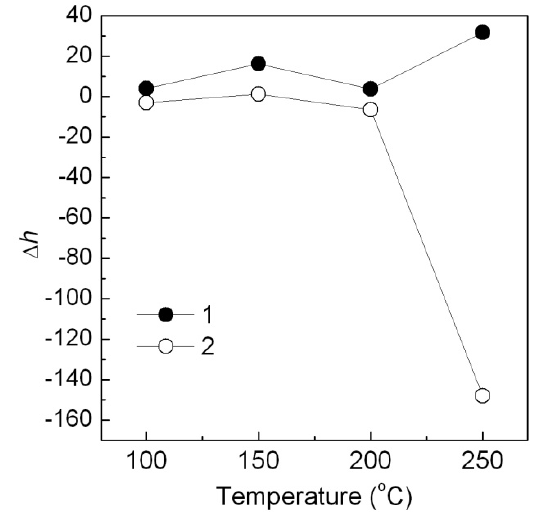
(PO ) /ABB6B hybrid ( 1 ), 3 4 2